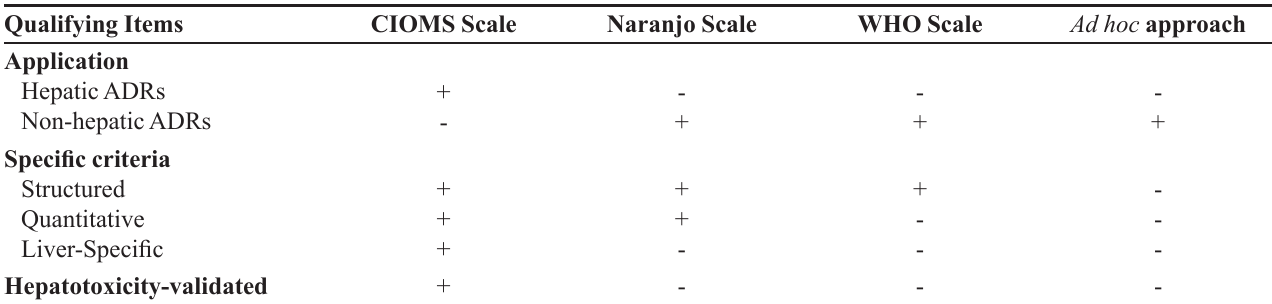
TABLE II - Criteria involved in each causality assessment method (Teschke et al., 2012b)